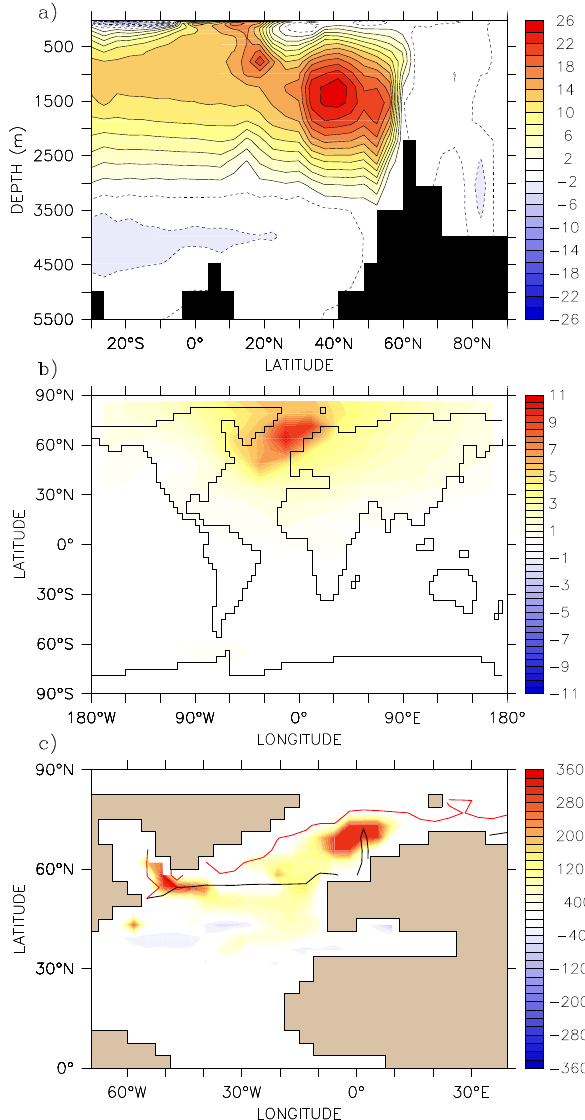
Fig. 1. Time series of forcings and relevant climatic variables: (a) CO 2 forcing in ppmv; (b) wind amplification factor over the Drake Passage (no units); (c) anomalies of North Atlantic SAT (67.5 ◦ N 11 ◦ W, in the Nordic Seas) with respect to the stadial state in K; (d) AMOC strength in Sv; (e) anomalies of Antarctic SAT (86.2 ◦ S 11 ◦ E) with respect to the stadial state in K. Black, red and blue lines show the simulation combining CO 2 and wind forcings, the CO 2 -only experiment, and the wind-only forced run, respec- tively. Black, red and blue shaded bars indicate the transition stages for the simulation combining CO 2 and wind forcings, the CO 2 -only experiment and the wind-only forced run, respectively.